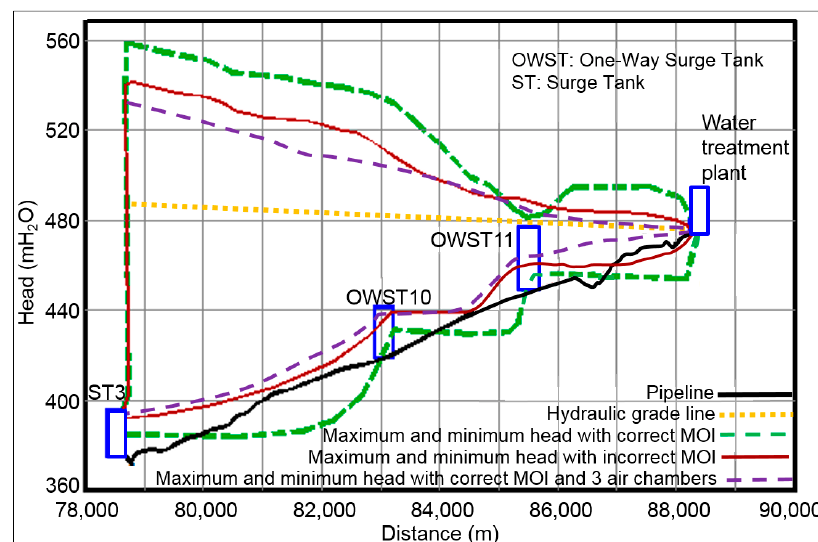
Figure 6. Maximum and minimum head envelopes for the fourth pipeline segment, considering the incorrect moment of inertia (original design), the correct moment of inertia (MOI), and the correct moment of inertia and the three additional air chambers, following the simultaneous power failure of the five pumps at Pumping Plant 4.